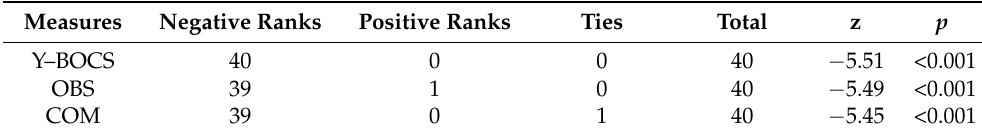
Table 5. Wilcoxon signed-rank